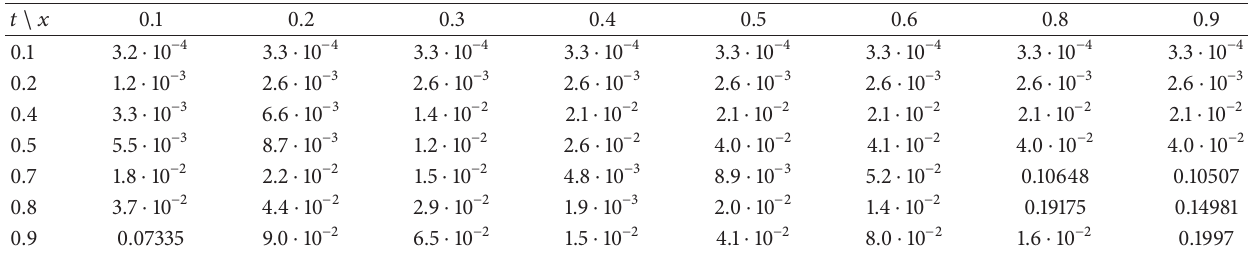
Table 2: Maximum errors for Example 4.